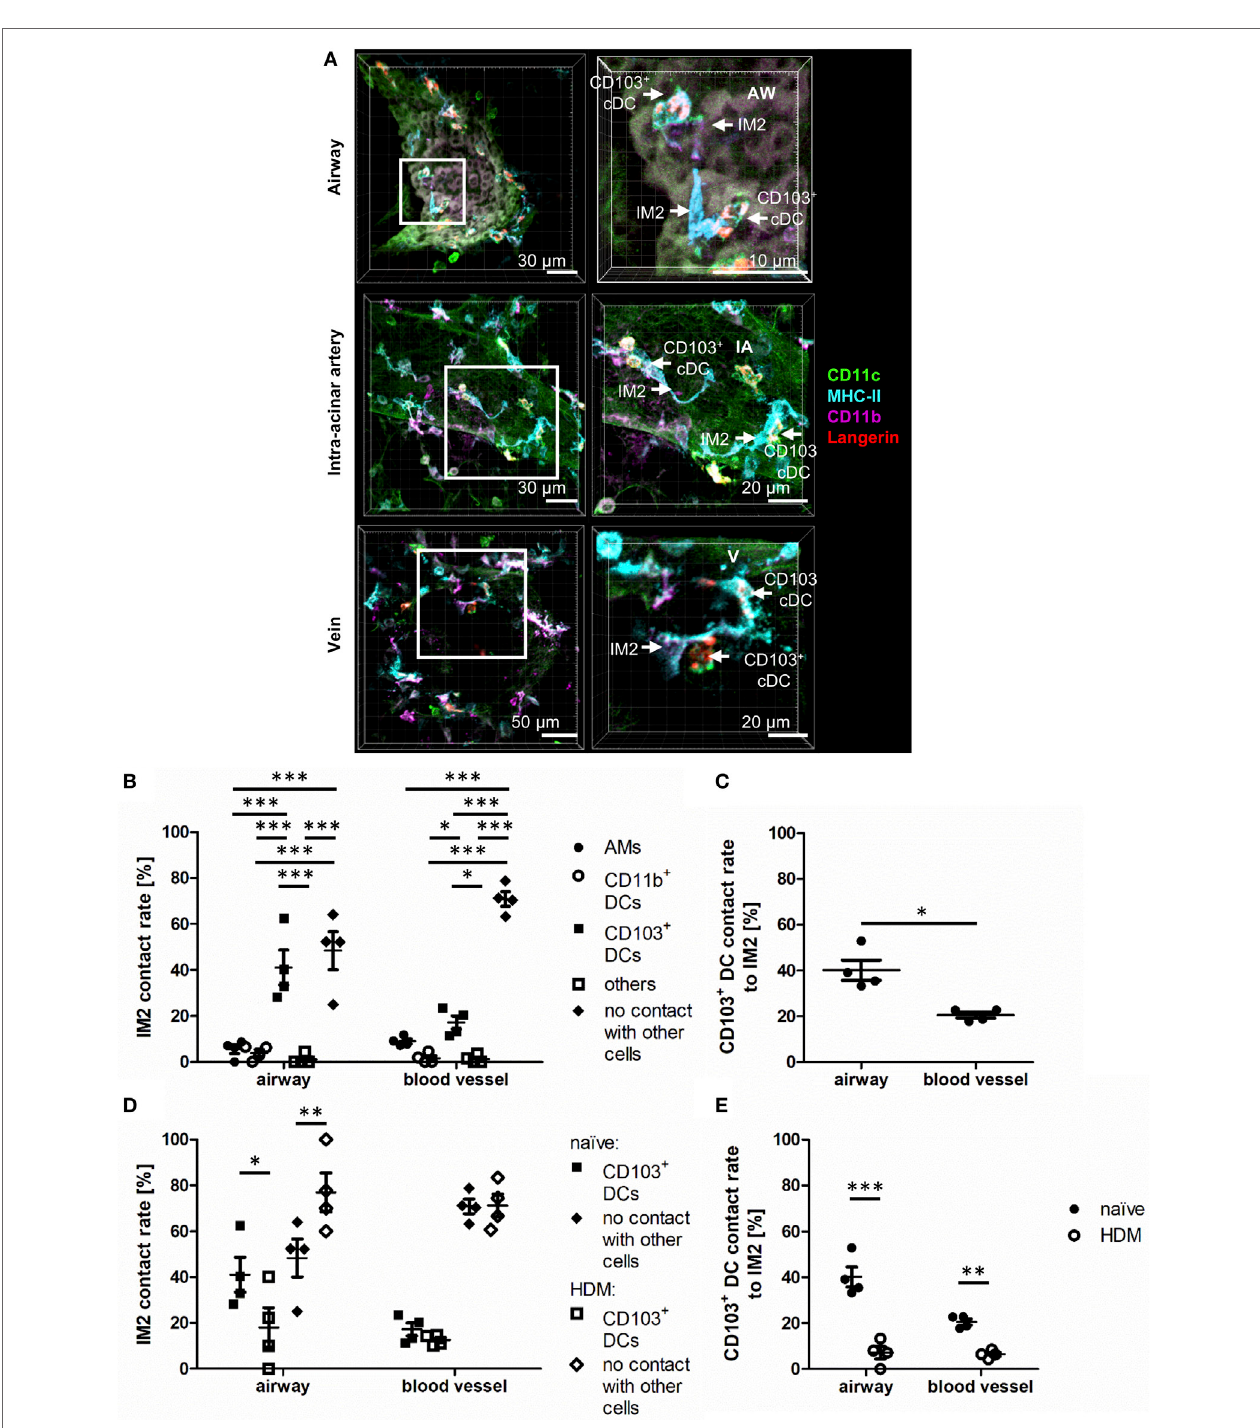
FigUre 8 | Interstitial macrophages (IM)2 and CD103 + dendritic cells (DCs) form specific contacts around AWs. Naive C57BL/6 mice were anesthetized and immunized intratracheally with house dust mite extract (HDM) (100 µg). A total of 24 h after immunization, mice were sacrificed, precision cut lung slices (PCLS) (300 µm) were generated and stained with anti-CD11c (green), anti-MHC-II (turquois), anti-CD11b (purple), and anti-Langerin (red) ABs. Naive C57/BL6 mice served as controls (a) . Stained slices were evaluated with confocal microscopy. Contact rates at the AW epithelium and blood vessels of naive mice were determined between IM2 and other phagocytes (B) as well as between CD103 + DCs and IM2 (c) . Furthermore, the contact rates after HDM immunization were assessed at the AW epithelium and blood vessels between IM2 and CD103 + DCs (D) and CD103 + DCs and IM2 (e) . Abbreviations: AW, airway; IA, intra-acinar artery; V, vein. Data are representative of at least four independent experiments. Lines indicate mean ± SEM. Differences between groups were tested by two-way ANOVA (B,D,e) or Mann–Whitney U -test (c) for significance; * p < 0.05, ** p < 0.01, *** p <